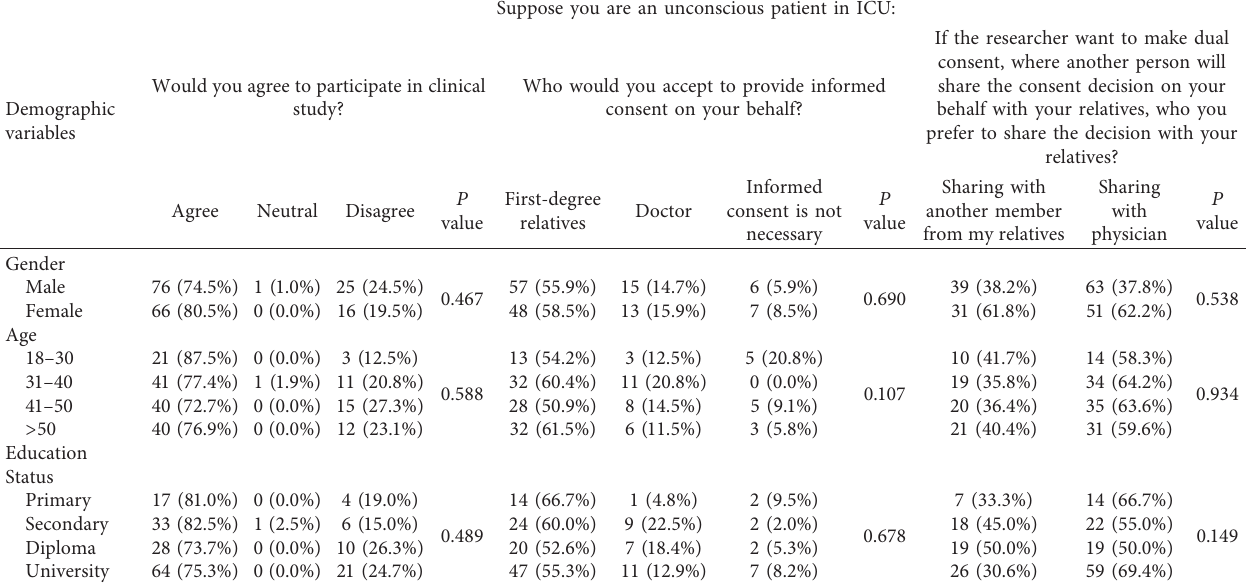
Table 5: Attitudes of patient’s relatives towards participating in clinical studies if they were unconscious patients in ICU per demographic variables.